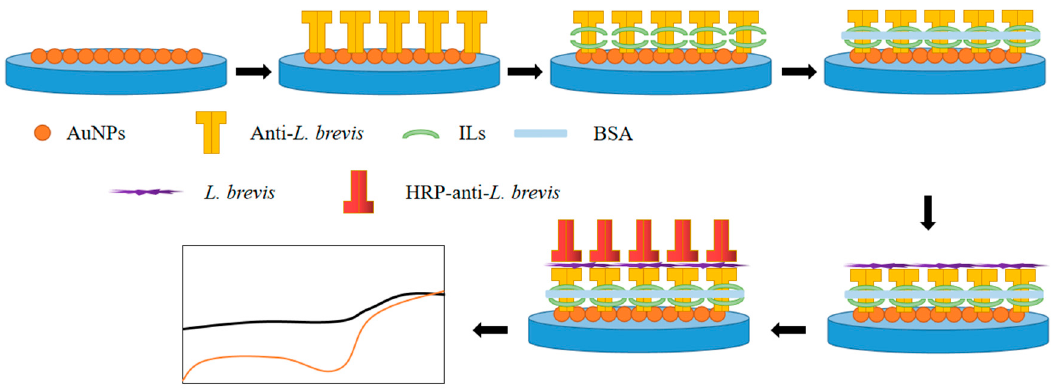
Figure 1. Scheme of preparation of Lactobacillus brevis immunosensor.